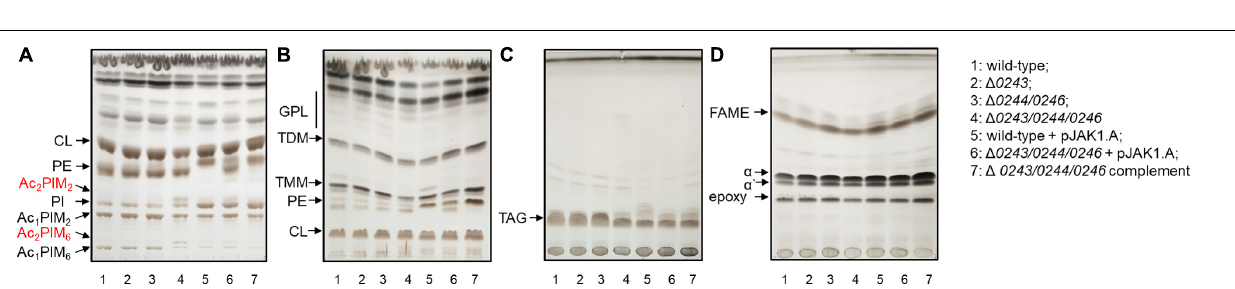
FIGURE 5 | M. smegmatis strains were grown in 7H9 medium (liquid and solid). (A) Colony morphology after 6 days of growth on 7H9 agar at 37 ◦ C. 1 µ L culture of OD 600 0.01, 0.001, and 0.0001 were spotted on the plate. Mutant (cid:49) 0243/0244/0246 shows a smooth colony phenotype. (B) Liquid cultures of wild type cells, (cid:49) 0243 , and (cid:49) 0244/0246 displayed significant clumping in 7H9 medium without Tween 80 compared to (cid:49) 0243/0244/0246 . This effect was reversed in the complemented strain. Tween 80 is a non-ionic emulsifier routinely added to mycobacterial liquid cultures in order to reduce cell aggregation (Lyon et al., 1963). All experiments were performed at least three times and one representative dataset is shown.